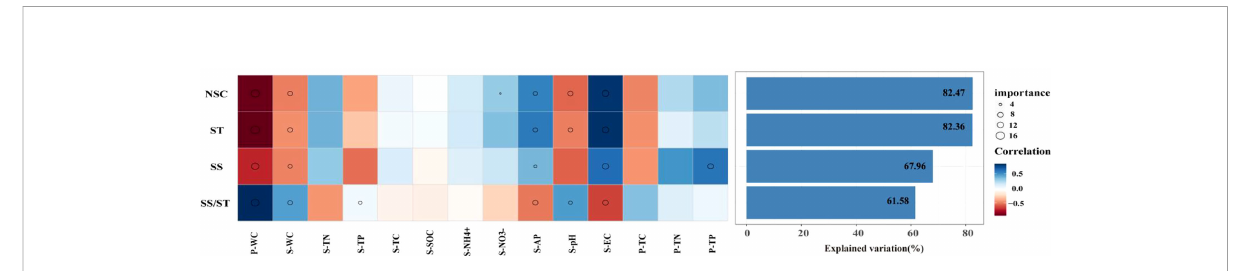
FIGURE 3 Contributions of abiotic factors to the NSC and its components of Syntrichia caninervis based on Spearman ’ s correlation and random forest model. Circle size represents the variables ’ importance (i.e., percentage of increase of mean square error calculated via random forest model). Colors represent Spearman ’ s correlations. Plant water content (P-WC), soil water content (S-WC), soil electrical total nitrogen (S-TN), soil total phosphorus (S-TP), soil total carbon (STC), soil organic carbon (S-SOC), ammonia nitrogen ( S − NH + 4 ), soil nitrate nitrogen ( S − NO − 3 ), soil available phosphorus (S-AP), soil Ph (S-pH), soil conductivity(EC), plant total carbon(P-TC), plant electrical total nitrogen (P-TN), plant total phosphorus